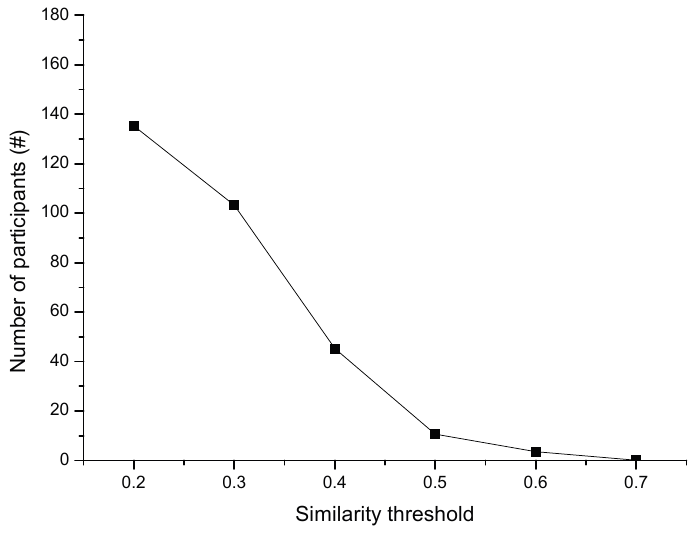
Figure 5. The number of participants with different similarity threshold.